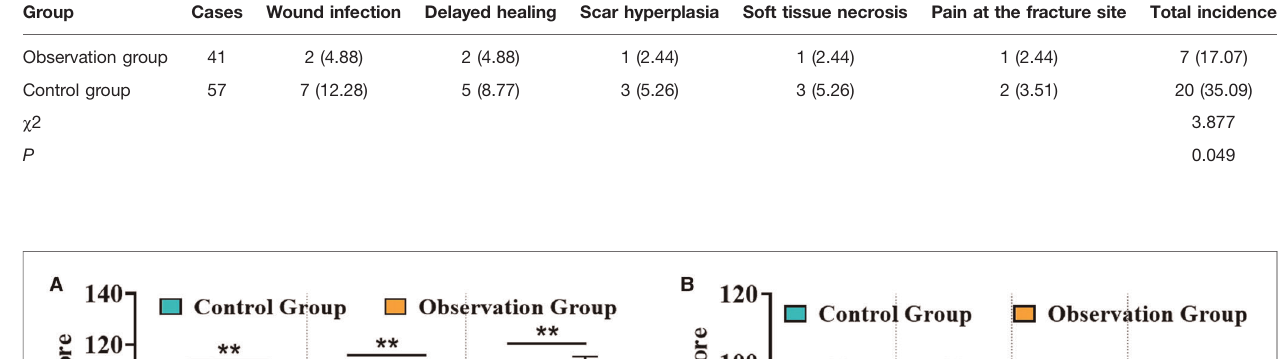
TABLE 2 | Comparison of postoperative complications. Group